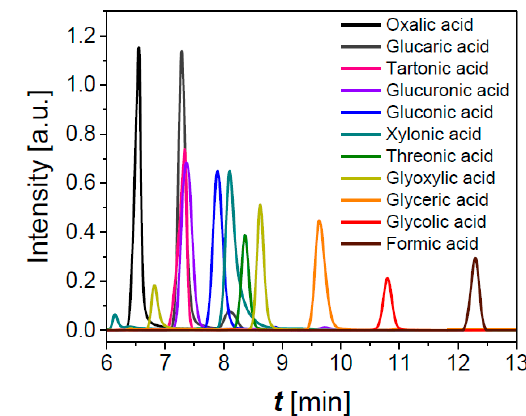
Figure 8. Chromatograms of standard solutions of any possible C1 to C5 degradation products from glucose and xylose oxidation (except carbonate and CO 2 ): 0.10 mol L − 1 gluconic, xylonic, glyceric, glycolic, glyoxylic, oxalic, formic, glucaric and glucuronic acids, and 0.025 mol L − 1 threonic